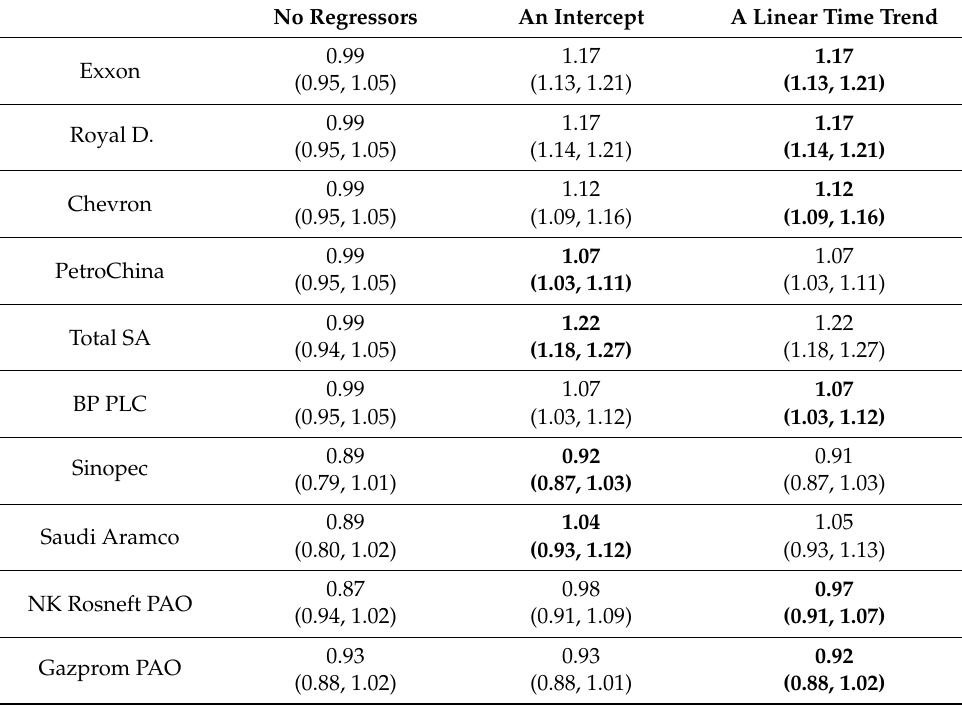
Table 4. Estimates of d for the betas with